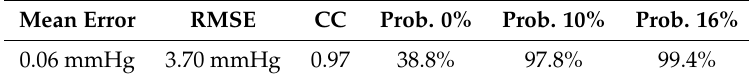
Table 2. Blood pressure estimation approach after Chen et al. [29]: Performance measures applied in the original publication including mean error, correlation coefficient, root mean square error (RMSE) and a probability of error distribution (Prob. 10% = range of normalized error within 10%) Mean Error